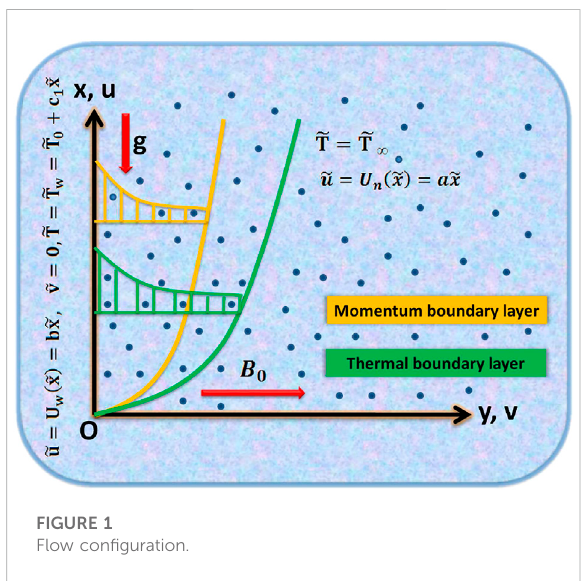
FIGURE 1 Flow con fi